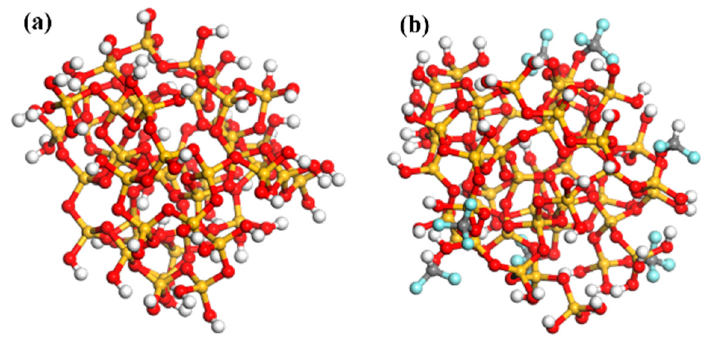
Figure 6 . Molecular model. ( a ) SiO 2 . ( b ) FSiO 2 .